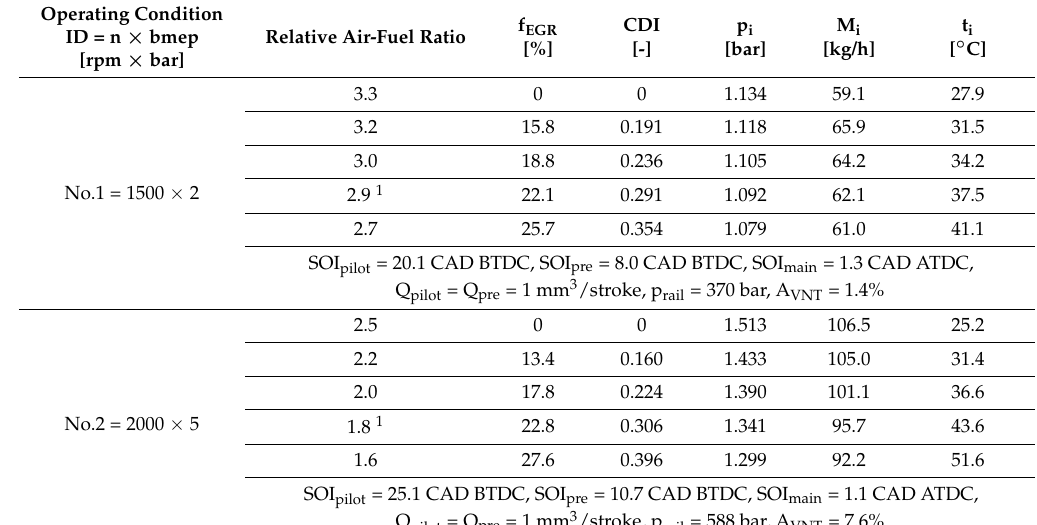
Table 3. Schedule of experimental activities for test Set 1 and average values of operating parameters (operating conditions No.1 and 2).